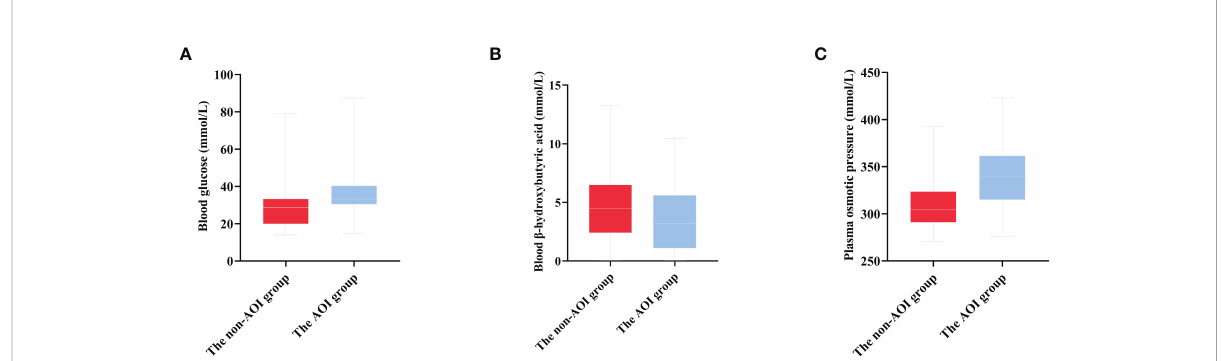
FIGURE 2 The distribution of blood glucose, blood ketone and plasma osmotic pressure in the two groups (A) The distribution of blood glucose in two groups [(30.43, 40.36) 33.30 vs. (19.90, 33.40) 28.70, P < 0.001]. (B) The distribution of blood b -hydroxybutyric acid in two groups [(1.10, 5.60) 3.18 vs. (2.40, 6.50) 4.50, P = 0.031]. (C) The distribution of plasma osmotic pressure in two groups [(290.83, 323.75) 304.20 vs. (315.0, 361.6) 339. 0, P <